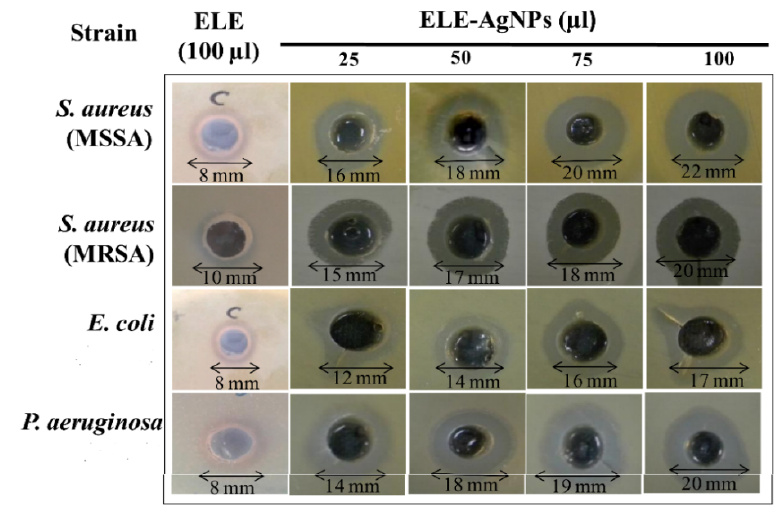
Figure 10. Assessment of antibacterial activity of ELE and ELE-AgNPs by disk diffusion assay. Reproduced from [106] with permission of Public Library of Science.